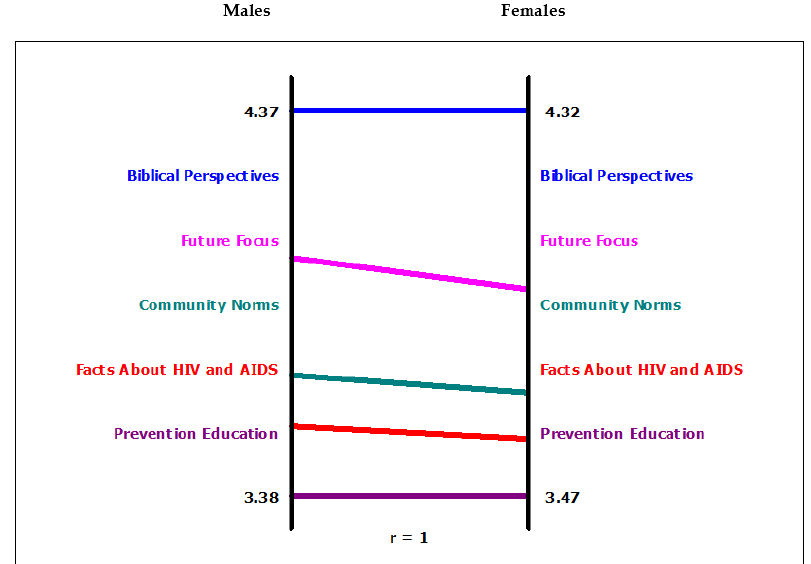
Figure 1. Pattern map for concordance of agreement between males and females with first sex in their framing and prioritization of influences on their sexual decision making. Note the numbers on the vertical axis are mean group scores.